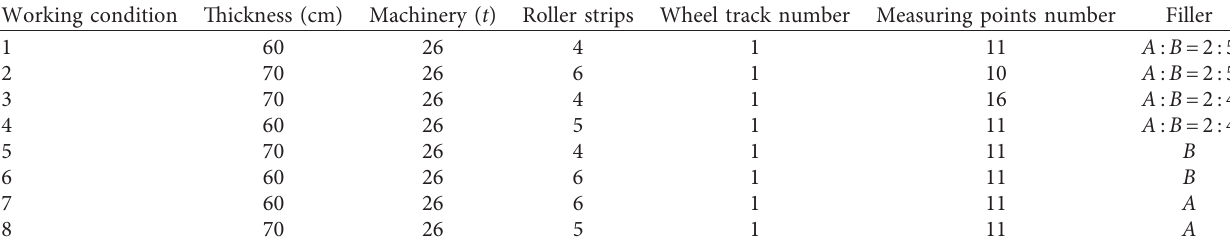
Table 2: K8 test condition table.